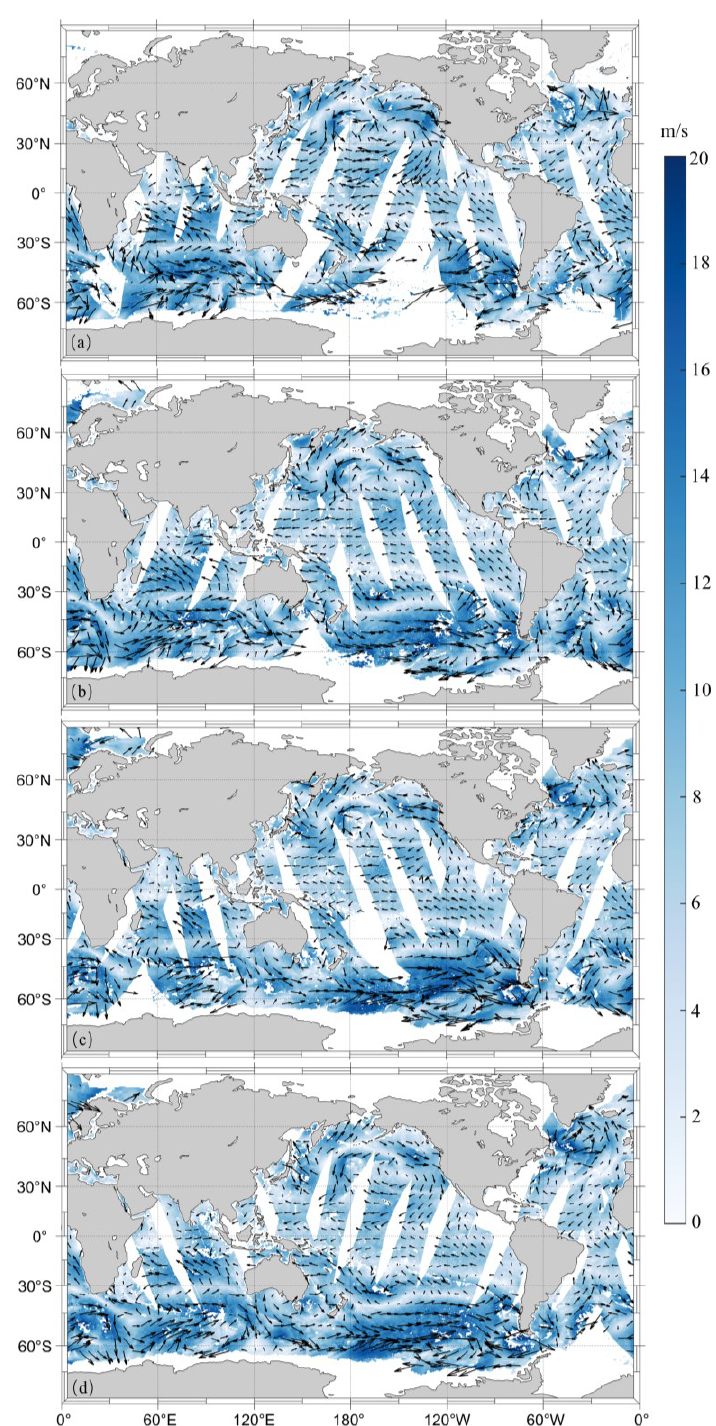
Figure 1. Six-hourly coverage of the three HSCATs on May 7, 2022, at ( a ) 00 h, ( b ) 06 h, ( c ) 12 h, and ( d ) 18 h, respectively. Color bars indicate the wind speed.